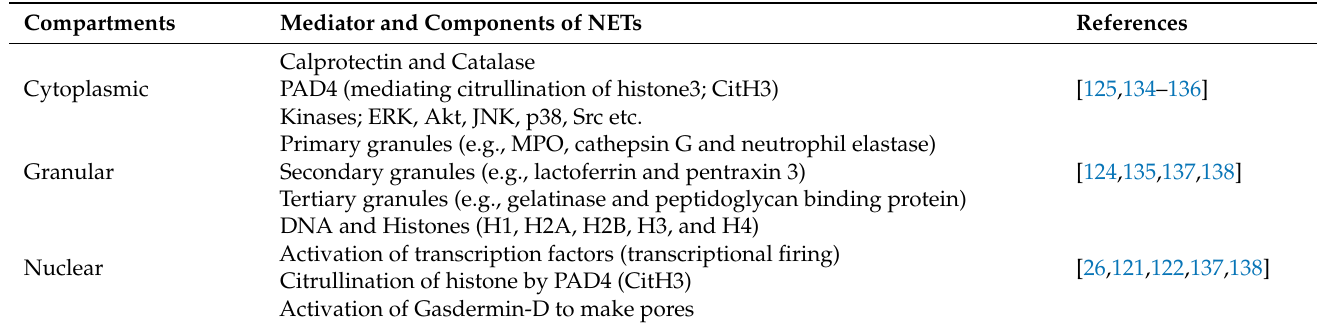
Table 2. Major mediators and components of